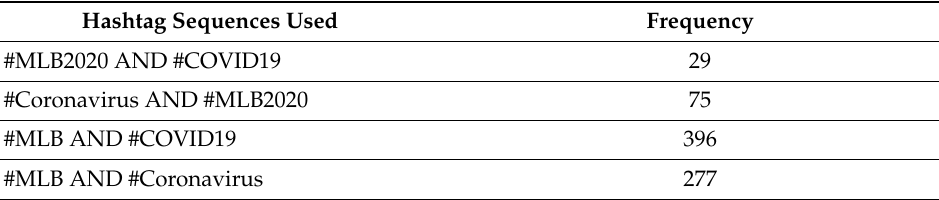
Table 1. Description of hashtag sequences